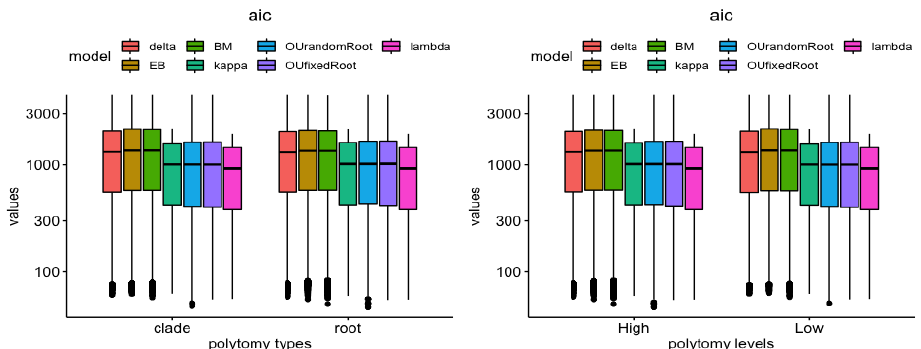
Figure 18. AIC concerning different models and polytomy types. Left panel : polynomial type vs. models. Right panel : polynomial level vs. models.